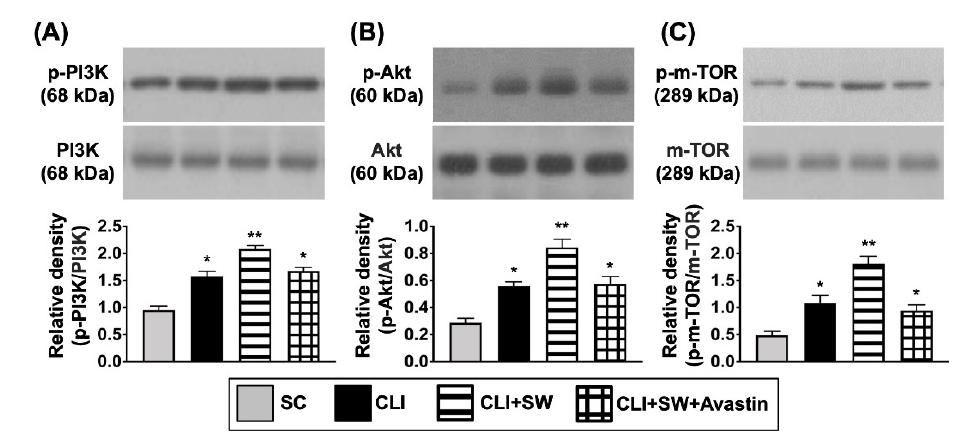
Figure 7. The protein expressions of cell proliferation/growth/survival signaling in CLI quadriceps muscle by day 14 after CLI induction. ( A – C ) Western blot analyses showed the results of protein expressions of phosphorylated (p)-PI3K ( A ), p-Akt ( B ) and p-m-TOR ( C ). * for p < 0.05, ** for p < 0.01. n = 6 for each group. SC = sham-operated control; SW = shock wave.